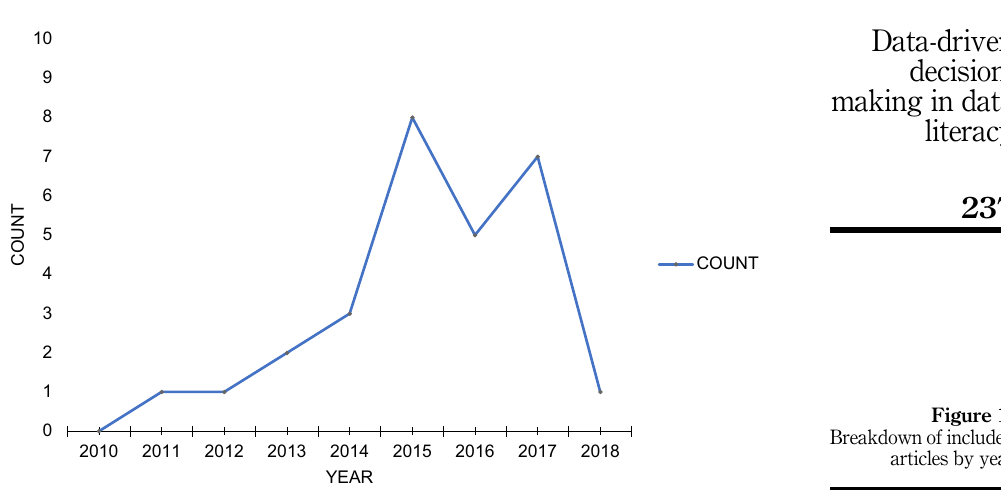
Figure 1. Breakdown of